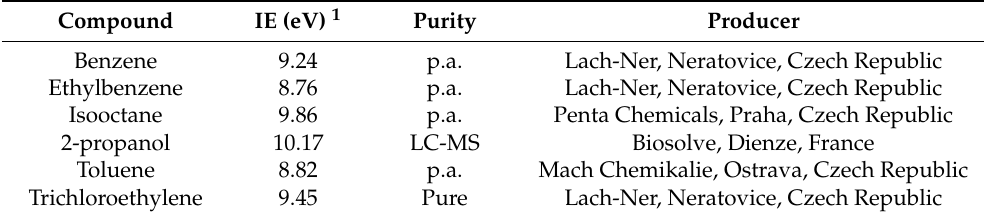
Table 2. Overview of used chemicals, their ionization energies, purity and